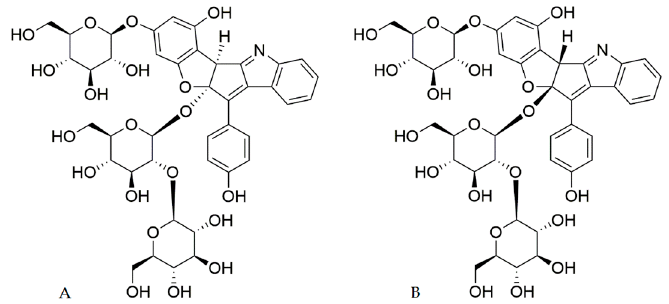
Figure 1. Structures of nudicaulin I ( A ) and II ( B ), flower pigments of Papaver nudicaule L.